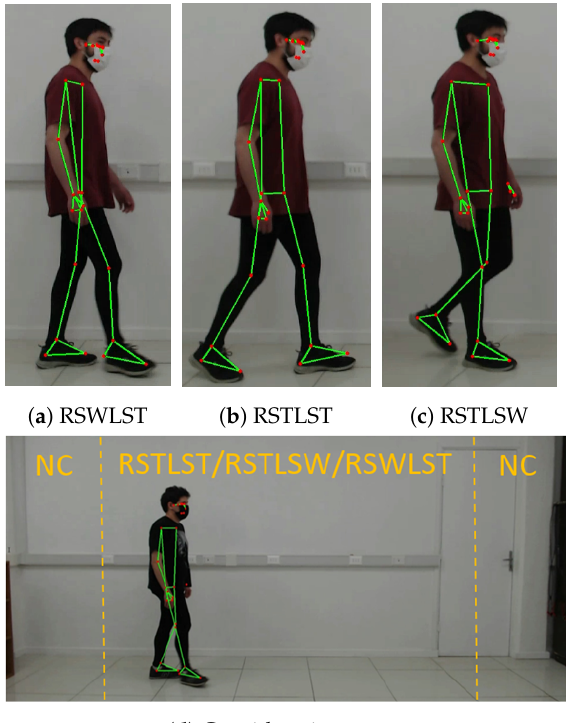
Figure 4. ( a ) Example of the right leg swing and left leg stance class; ( b ) Example of both leg stance classes; ( c ) Example of the right leg stance and left leg swing class; ( d ) Data consideration range in the camera frame of the lab